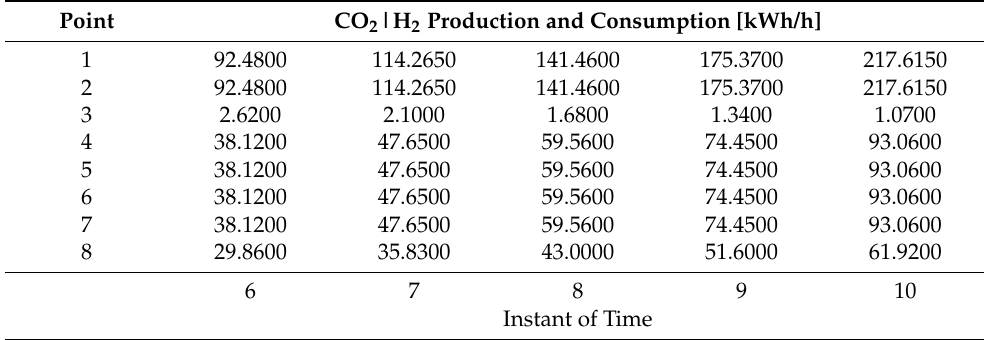
Table 3. CO 2 |H 2 production and consumption values for the pipeline network between the instants of time 6 and 10 with W F = 0.